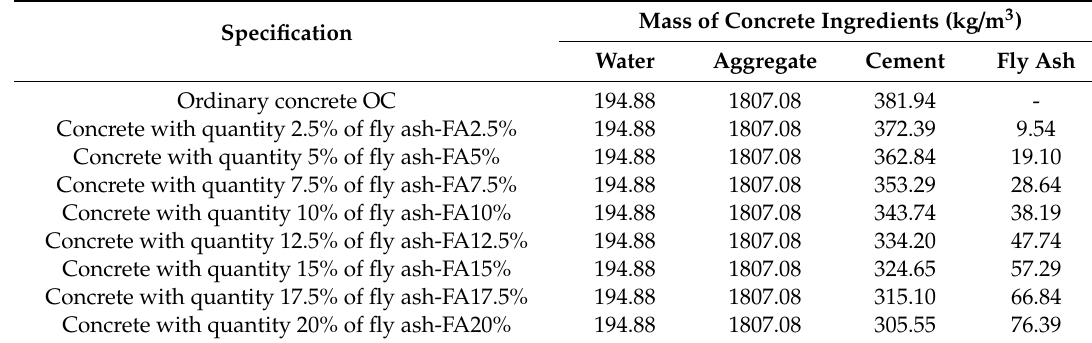
Table 4. Concrete mix proportions by